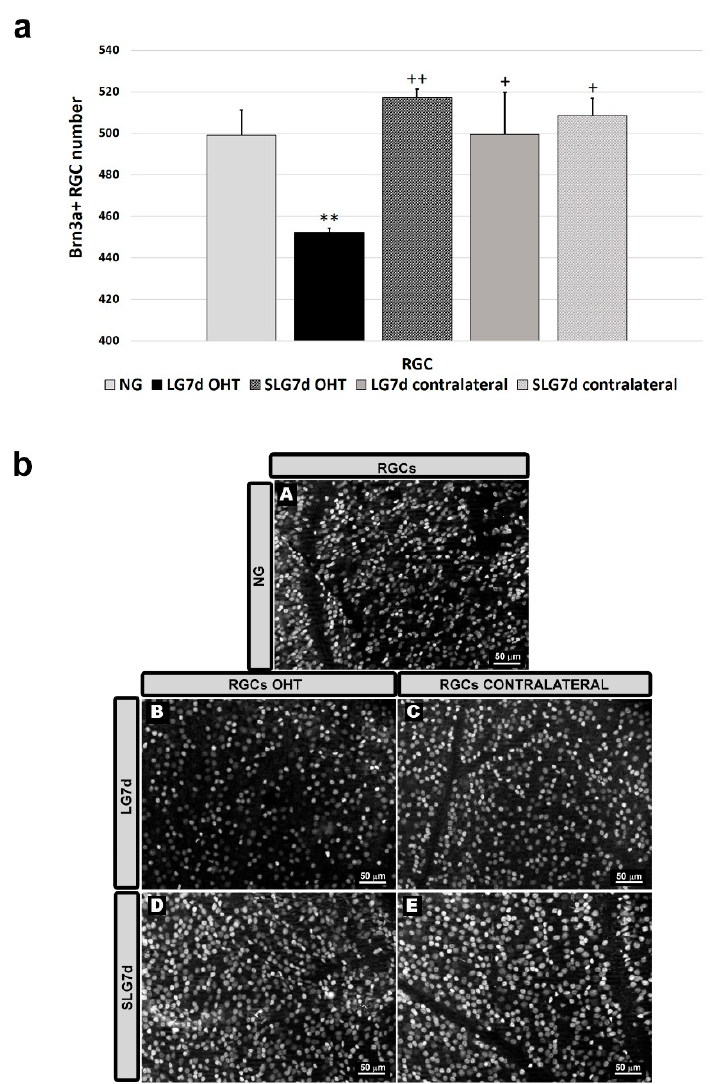
Figure 2. Comparison of numbers of Brn3a + retinal ganglion cells (RGCs) in eyes untreated and treated with sa ff ron extract at day 7 after ocular hypertension (OHT) induction. ( a ) Histograms showing the mean number ( ± standard deviation, SD) of Brn3a + cells per area of 0.1502 mm 2 . ( b ) Immunohistochemical images of anti-Brn3a stained retinal whole mounts. ( A ) NG, ( B ) LG7d OHT, ( C ) LG7d contralateral, ( D ) SLG7d OHT eyes, and ( E ) SLG7d contralateral. Abbreviations: Naïve age-matched control (NG), lasered group contralateral (LG7d contralateral), lasered group ocular hypertension (LG7d OHT), lasered group contralateral + sa ff ron (SLG7d contralateral), lasered group ocular hypertension + sa ff ron (SLG7d OHT). Statistical significance indicators: ** p < 0.01 vs. NG; + p < 0.05, ++ p < 0.01 vs. LG7d OHT.